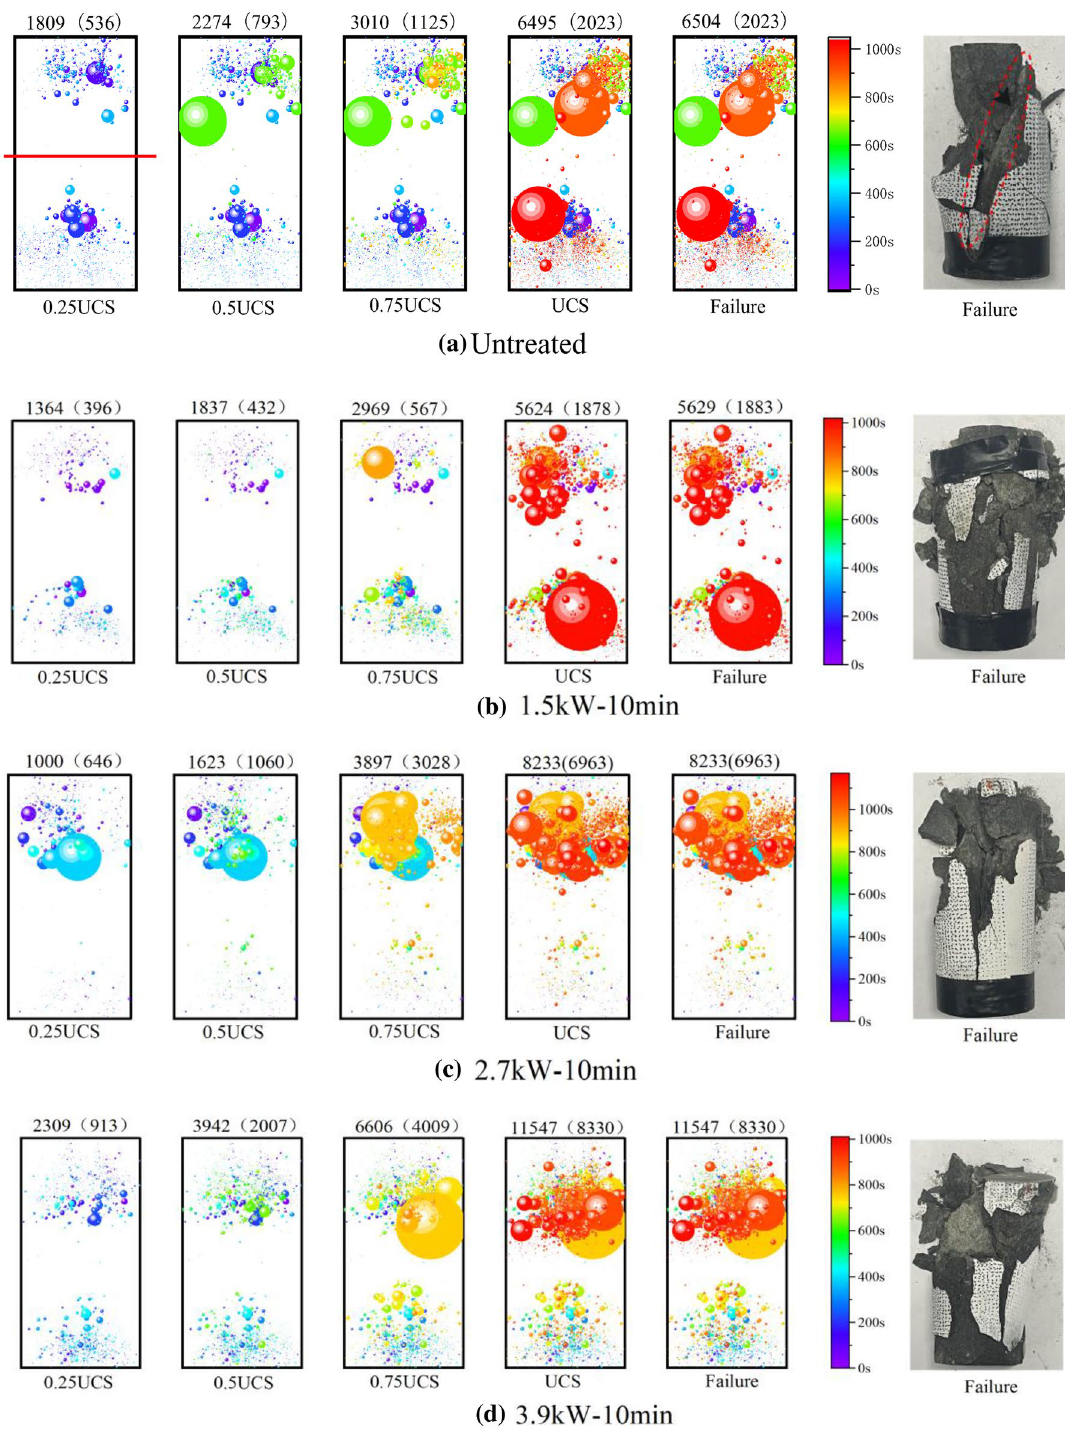
Figure 12. Spatial and temporal evolution of AE events in basalt samples: ( a ) Untreated; ( b ) at 1.5kW for 10 min; ( c ) at 2.7kW for 10 min; ( d ) at 3.9 kW for 10 min; ( e ) at 1.5kW for 34 min; ( f ) at 2.7 kW for 18.88 min; ( g ) at 3.9 kW for 13.08 min; ( h ) at 5.1 kW for 10